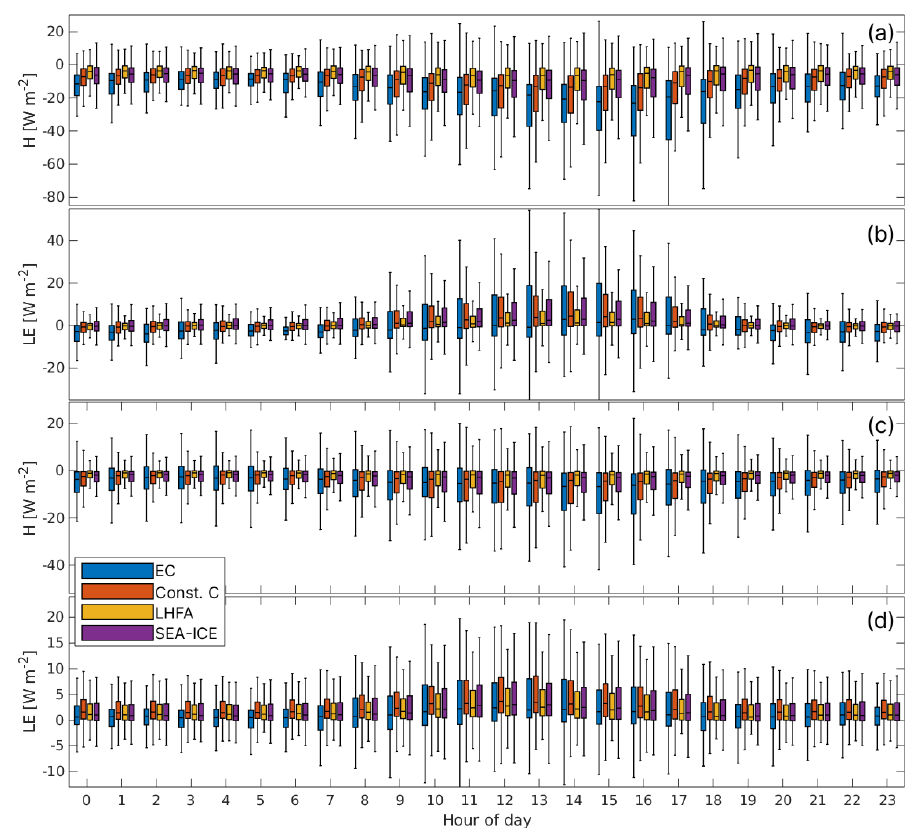
Figure 5. Daily variation of fluxes in EC and the three models. (a) H in melting surface conditions, (b) LE in melting surface conditions, (c) H in freezing surface conditions and (d) LE in freezing surface conditions. The line in the middle of each bar indicates the median, bar edges indicate the 25th and 75th percentiles and the whiskers extending from the bars indicate that 2 . 7 σ or 99.7% of values are within these boundaries. All times are in UTC + 2. Table 2. Linear fit parameters ( ax + b ) and statistics of 30min H values between EC and model data. Slope a Offset b Standard deviation CRMSE Correlation (Wm − 2 ) (Wm − 2 ) (Wm − 2